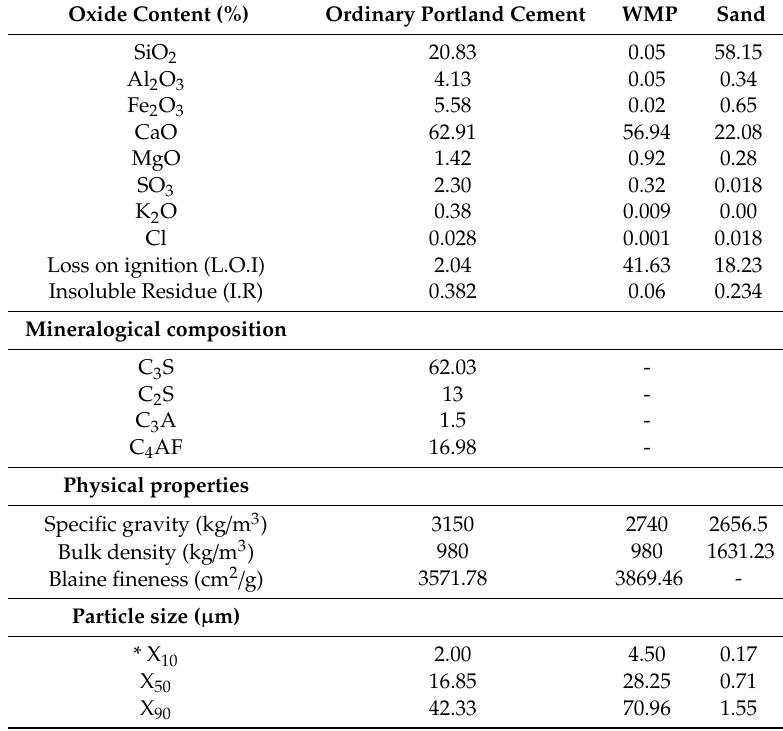
Table 1. Chemical compositions and physical properties of cement and marble powder